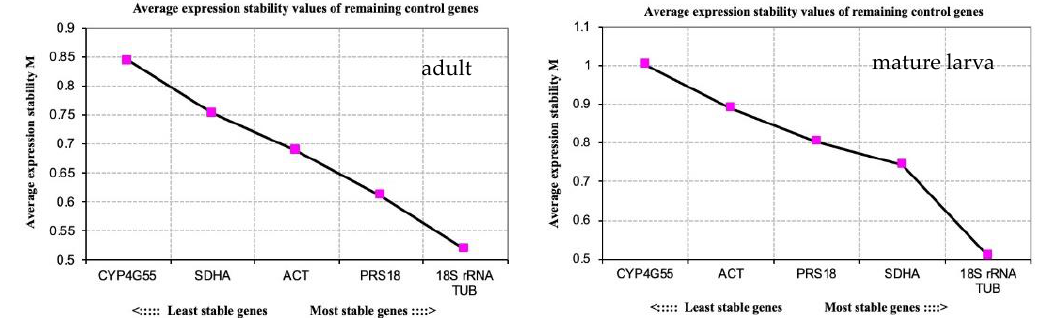
Figure 2. Expression stability of the candidate reference genes in adults and mature larvae of D. valens evaluated using geNorm.